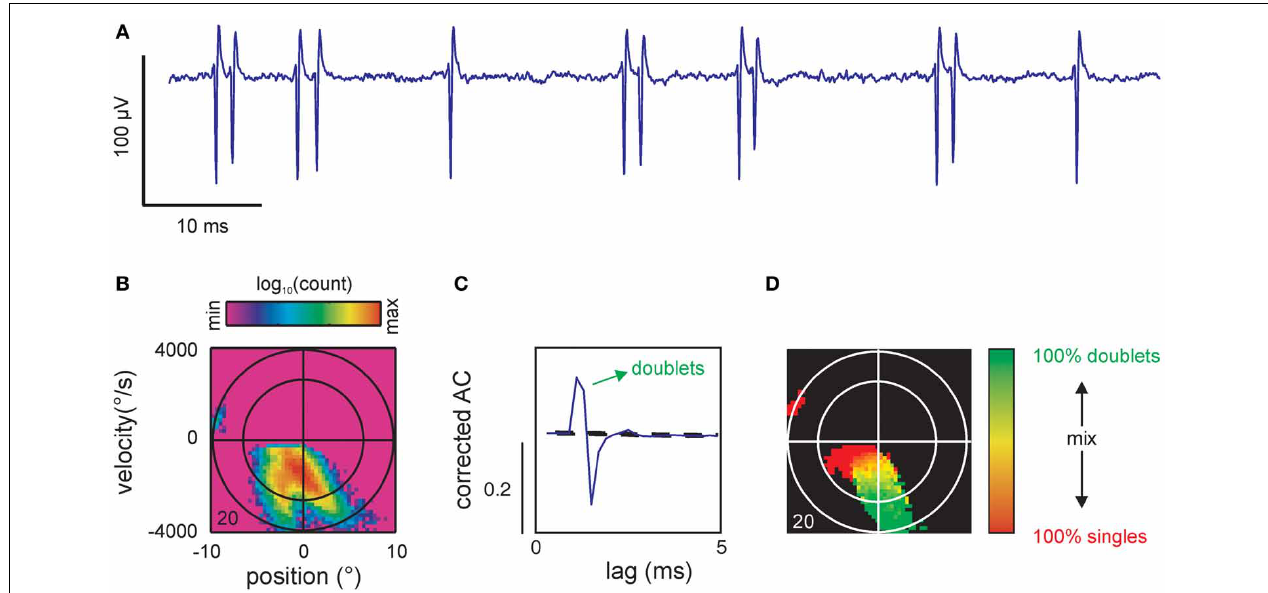
FIGURE 6 | Spike patterns. (A) Voltage trace of single unit recording showing 2 single spikes and 5 doublets. (B) Spike-triggered stimulus ensemble of cell 20. (C) Corrected autocorrelogram (AC) showing a prominent peak far exceeding the prediction interval [PI, (5, 95%), broken lines]. The peak is followed by a trough departing below the PI likely indicating a refractory period after the second spike of the doublet. The ordinate scales